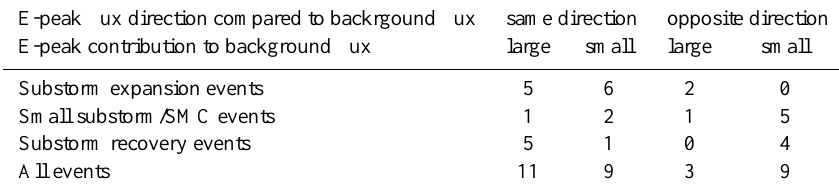
Table 2. Contribution of the E-peak related flux to the average background flux. E-peak flux direction compared to backrgound flux same direction opposite direction E-peak contribution to background flux large small